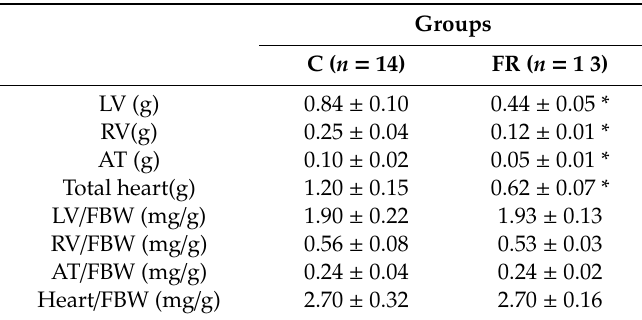
Table 2. Cardiac morphological post-mortem